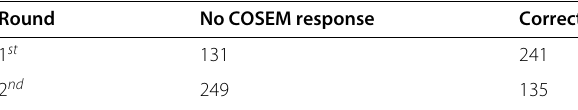
Table 7 The result of testing the DLMS/COSEM by using